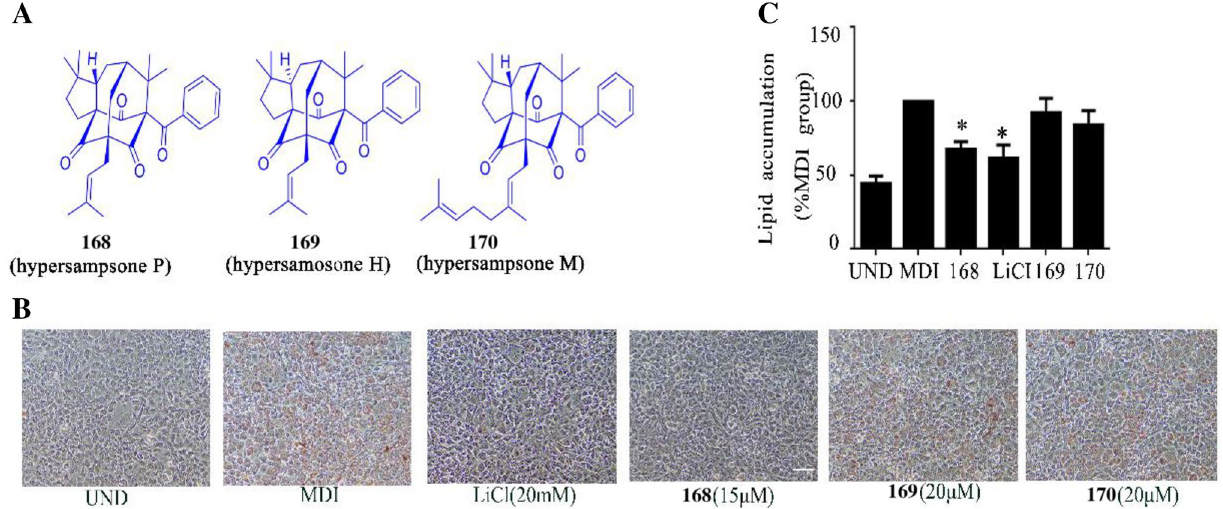
Fig. 2 Specificity of the compound with activity in adipogenesis. a Structures of the three compounds 168 (hypersampsone P), 169 (hypersampsone H) and 170 (hypersampsone M) with the most simi- larity. b Representative images of 3T3-L1 adipocytes treated with the